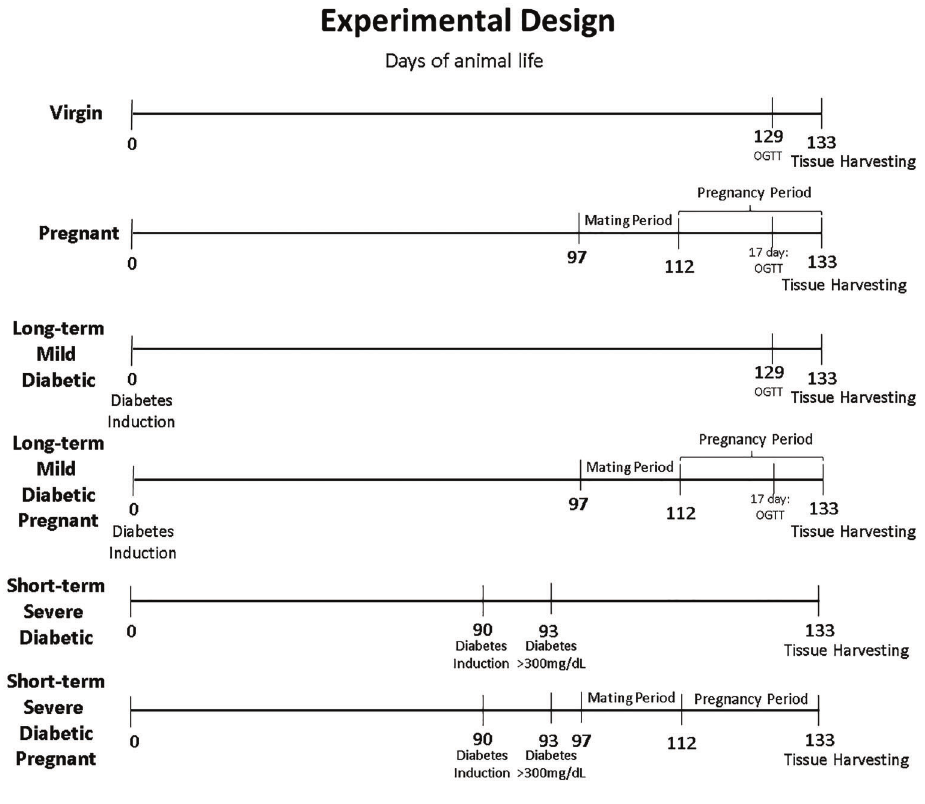
Figure 1. Experimental design. OGTT: oral glucose tolerance